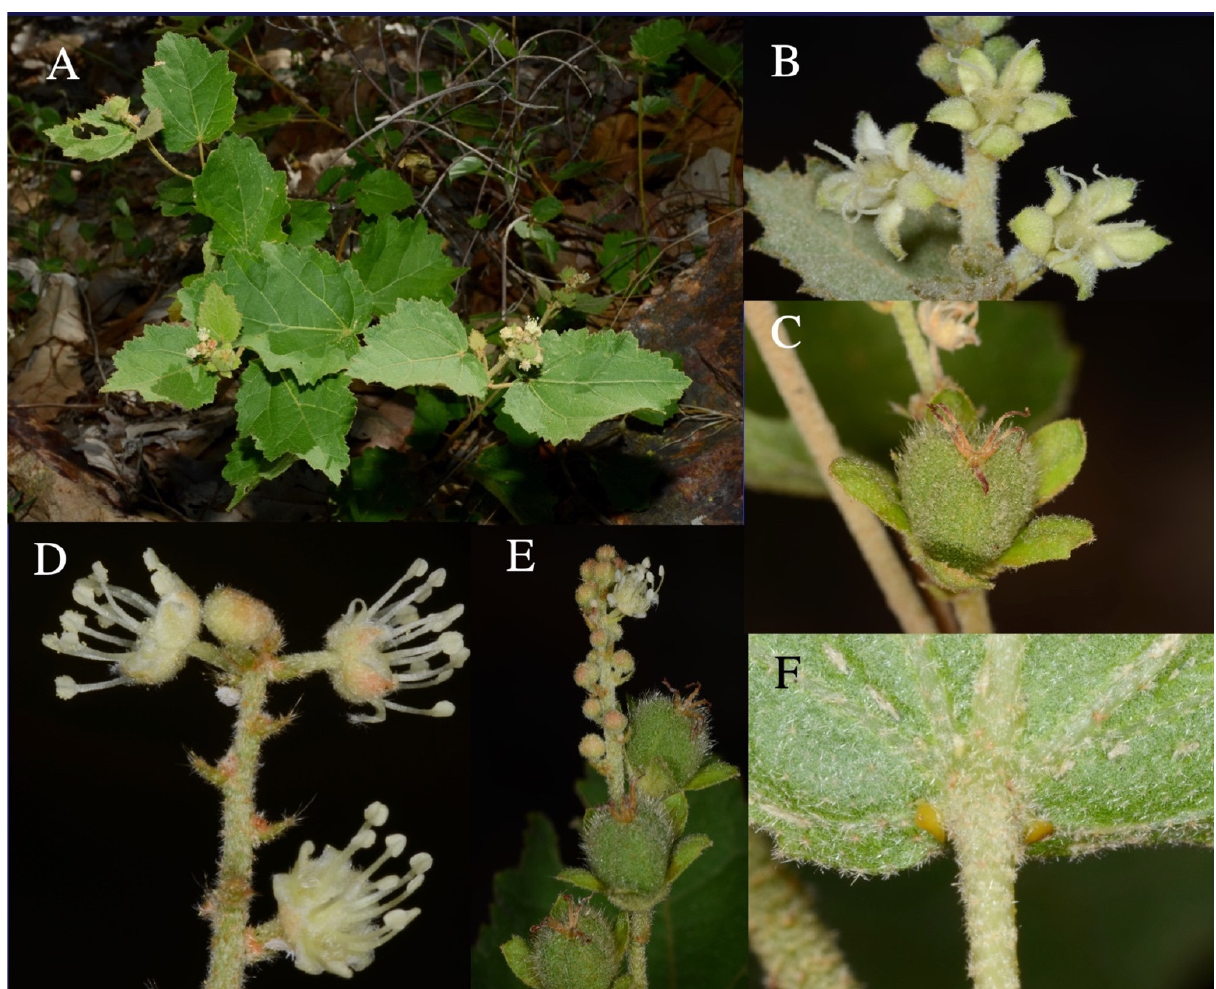
Figure A12. Croton repens. ( A ) Habit. ( B ) Pistillate flowers. ( C ) Fruit. ( D ) Staminate flowers. ( E ) Fruits and staminate flowers. ( F ) Underside of the lower leaf blade showing extrafloral